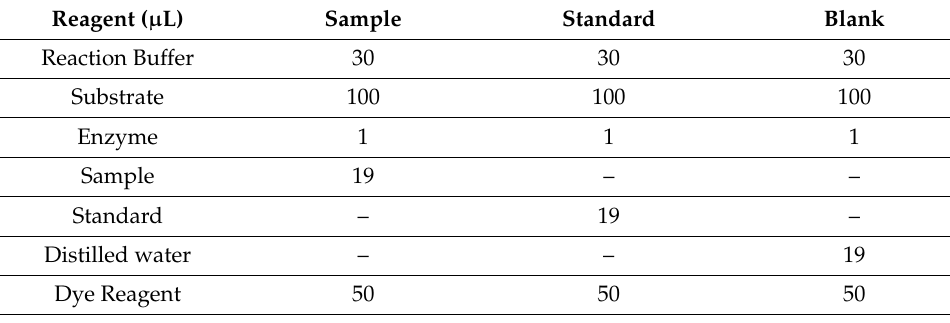
Table 1. The protocol of the kit